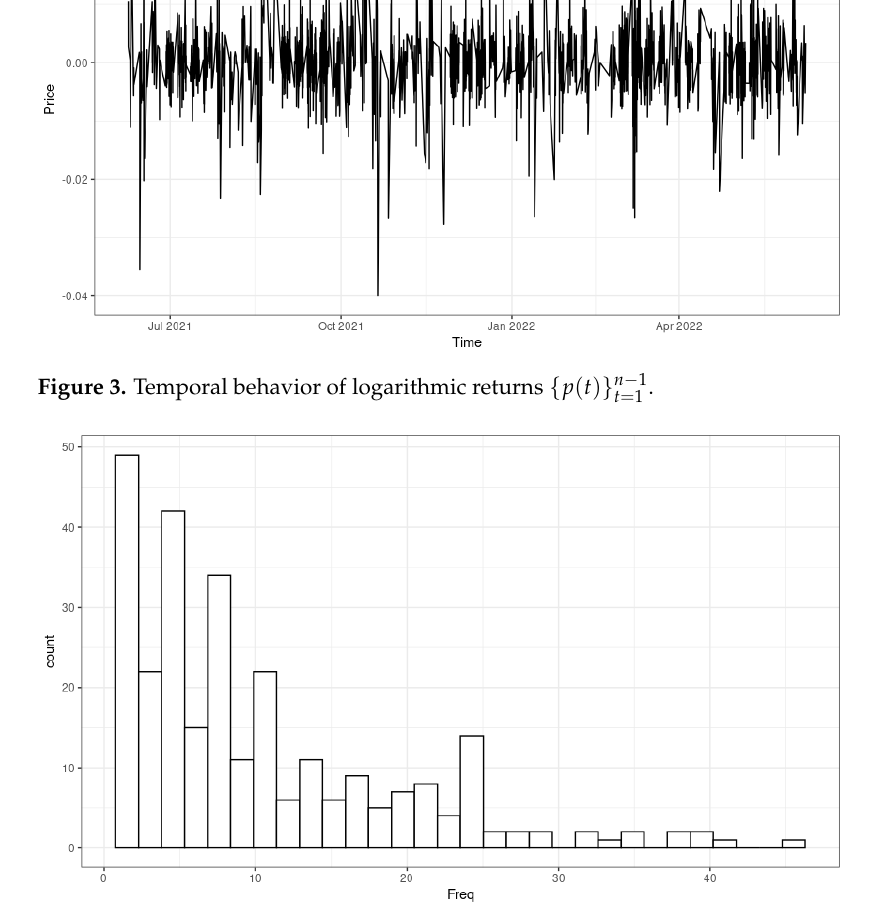
Figure 4. Distribution of intraday observations by